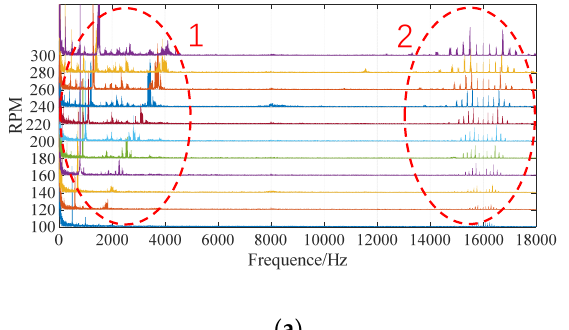
loaded operation; ( b ) sensorless FOC mode in the loaded operation.